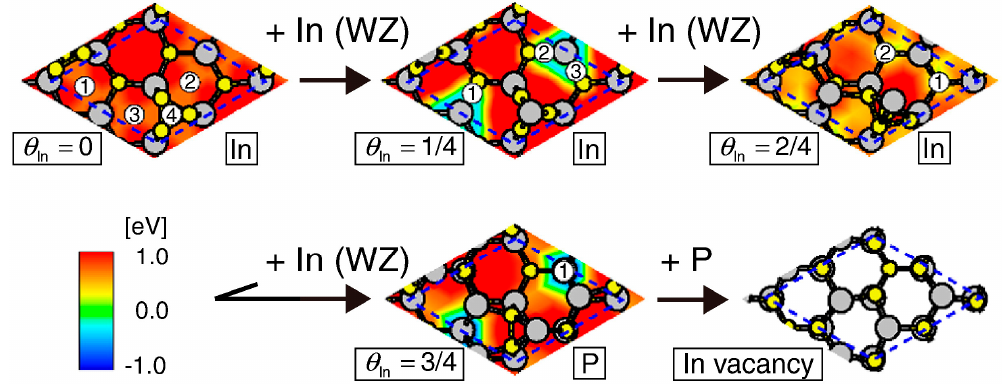
Figure 24. Growth process which is plausible under the growth conditions (A) and (B). The adsorption of a P atom occurs on the surface with θ In = 3/4. This growth process results in formation of an InP monolayer belonging to the WZ structure. Reprinted with permission from [97]. Copyright (2013) by Elsevier.